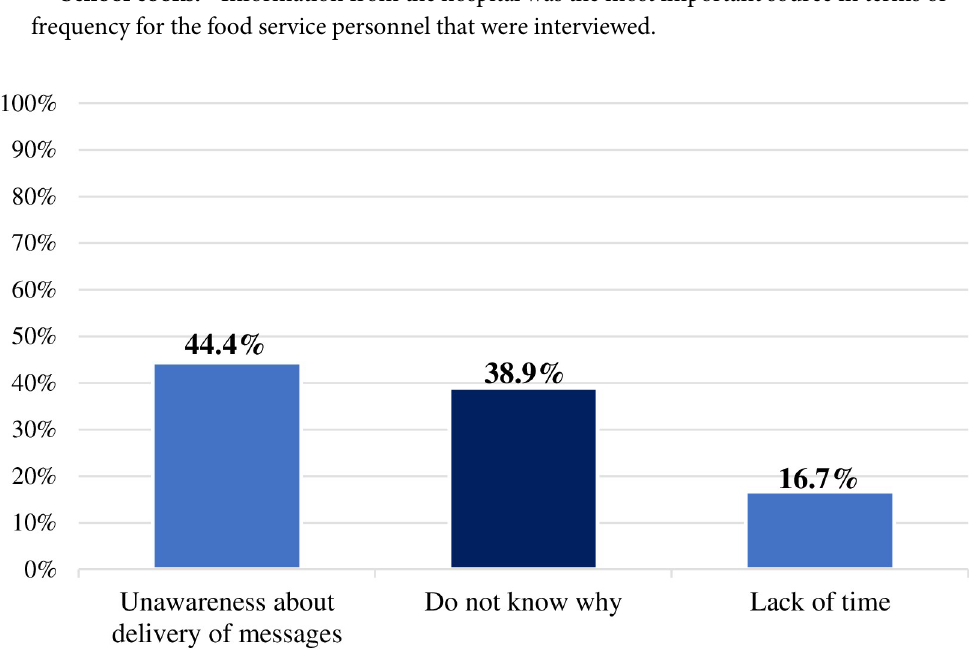
Fig 1. Self-reported reasons why caregivers had not heard or seen nutrition